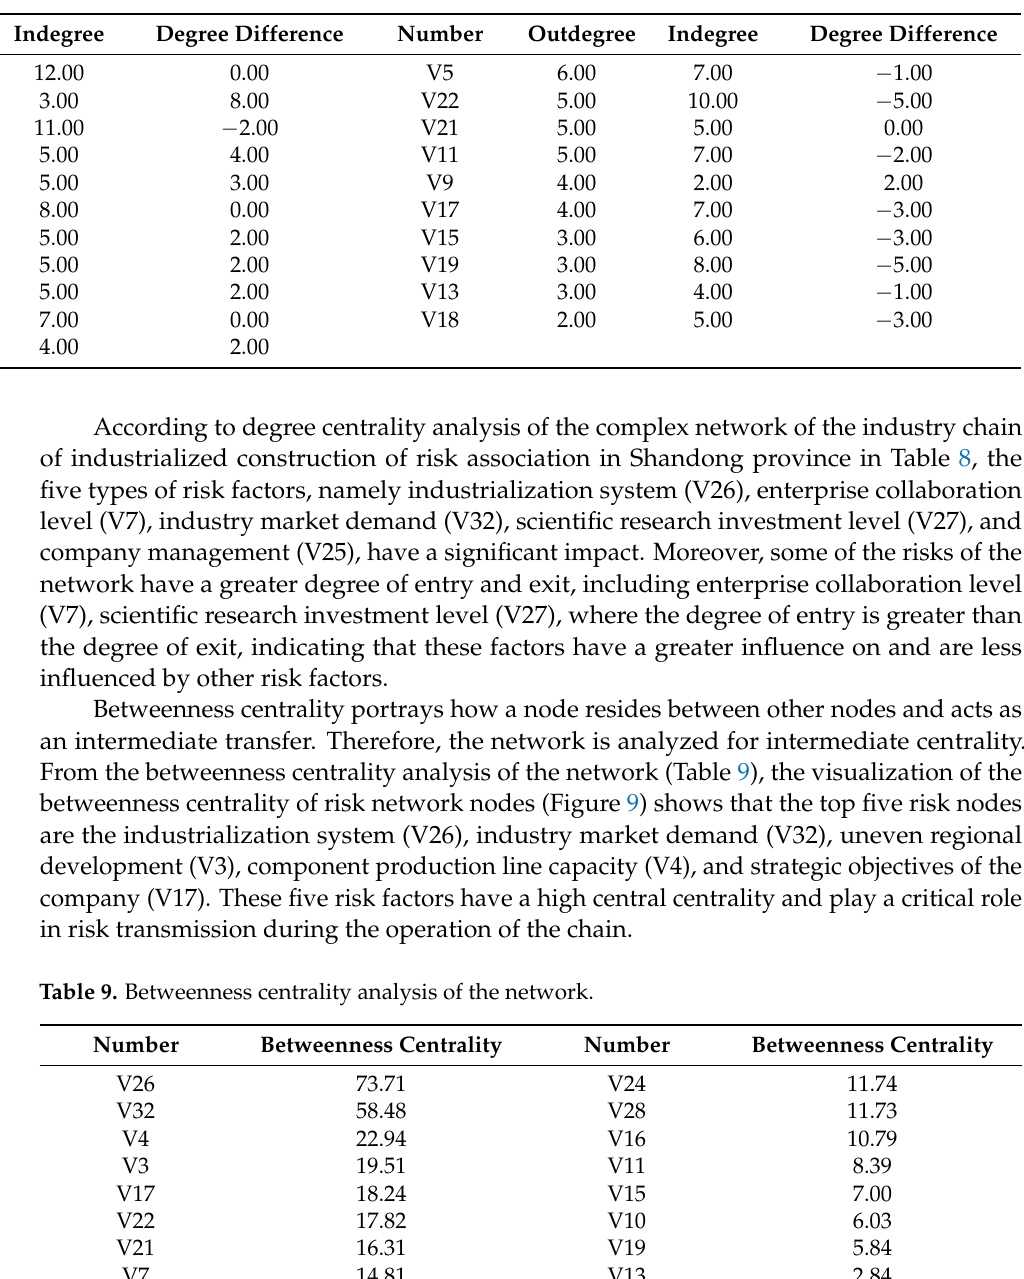
Table 8. Centrality analysis of the network.